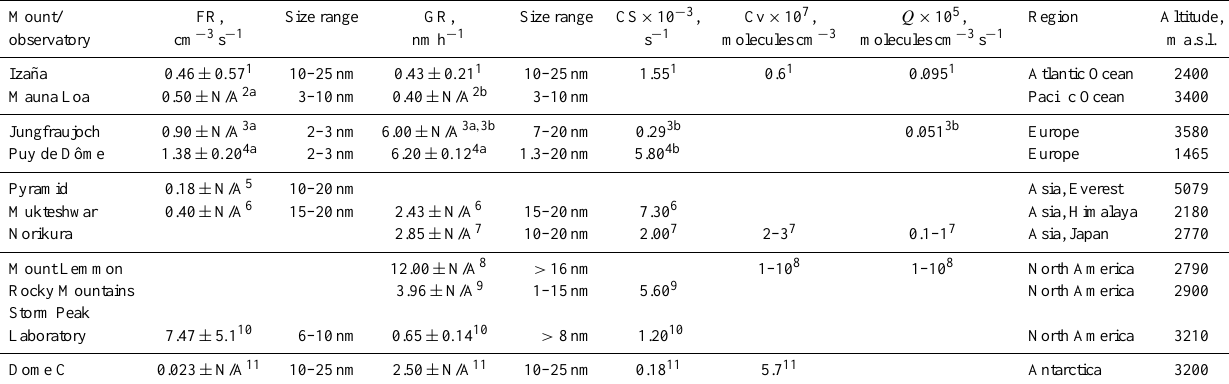
Table 3. Values of formation rates and growth rates observed in this and in other studies at mountain sites. Footnotes indicate the references.